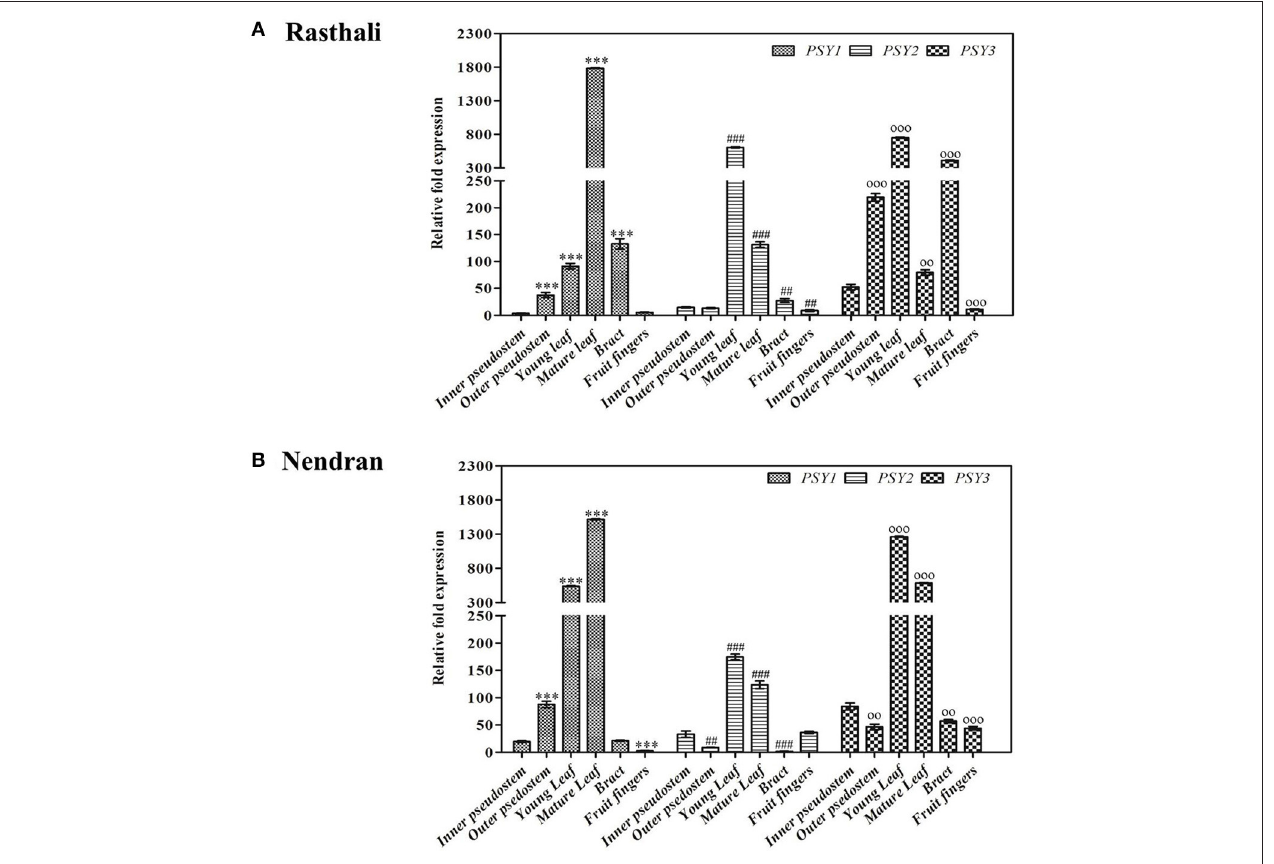
FIGURE 2 | Spatiotemporal real-time PCR expression analysis of PSY genes in banana vegetative tissues. Transcript expression profiles are presented in pseudostem (inner, and outer), leaf developmental stages (young, and mature), bract, and fruit fingers of Rasthali (A) , and Nendran (B) . The gene expression was normalized with reference to actin1 taken as internal control. Bars denote mean fold expression as compared to the lowest expressing gene in the group of samples ± SD. Statistical analysis was performed using Student’s paired t -test. Statistical significance was checked at P ≤ 0.05–0.001 and the symbols on the top of bars represents significance levels (##, oo, P ≤ 0.001; and ***, ###, ooo, P ≤ 0.0001) with respect to inner pseudostem in each